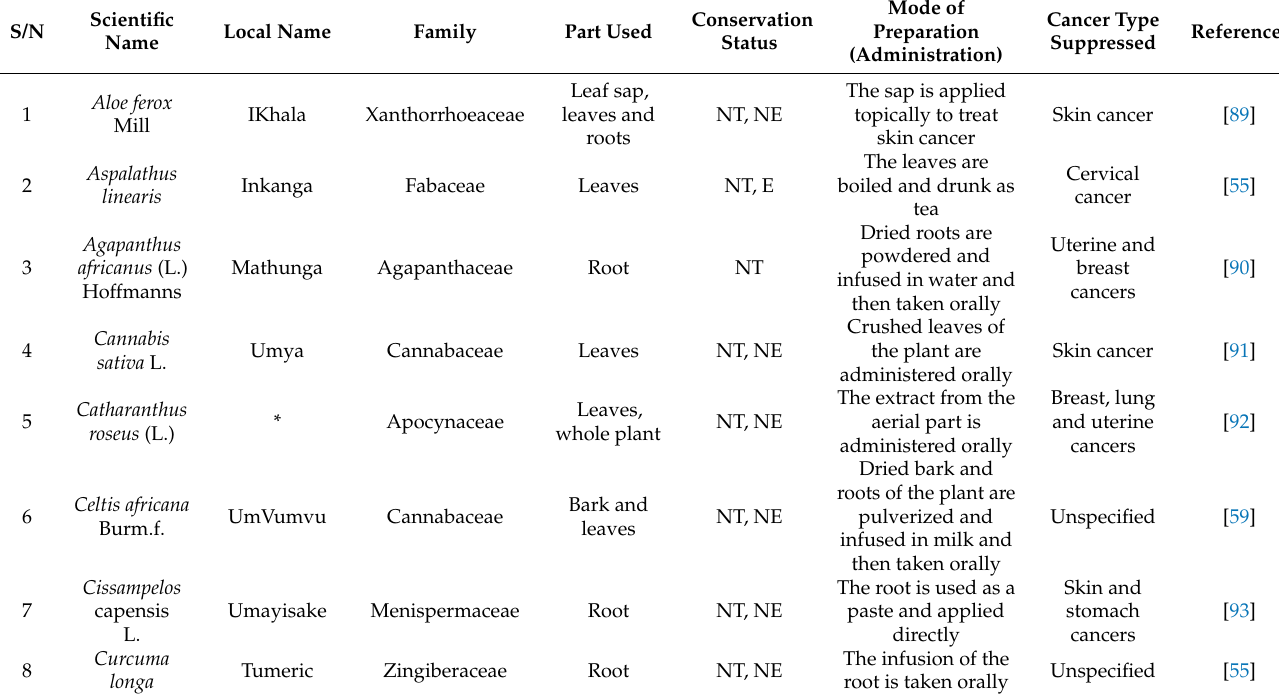
Table 2. Plants used for the treatment of cancer in the Eastern Cape